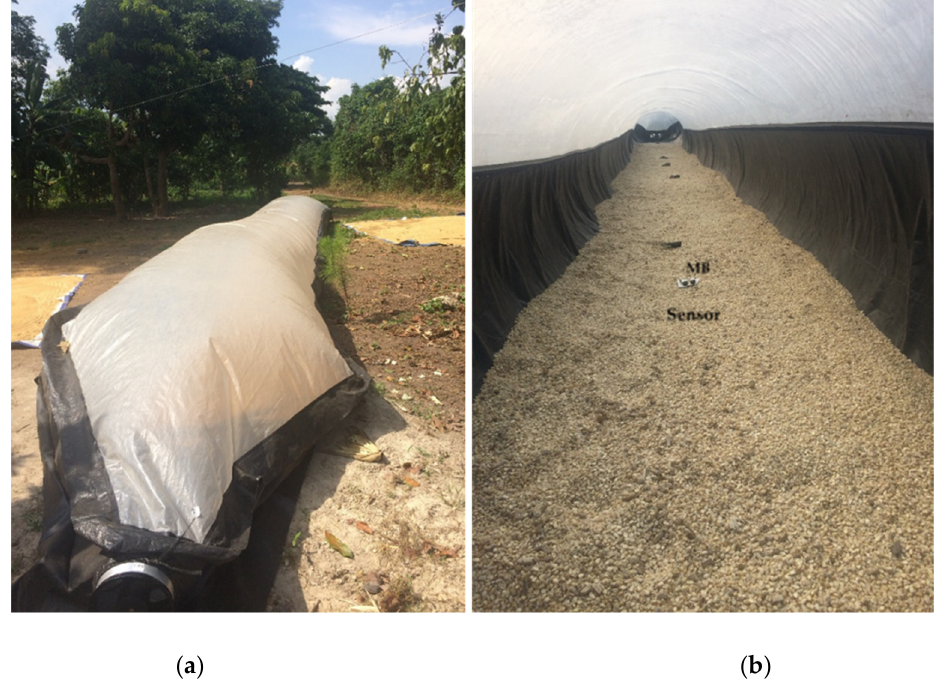
Figure 1. Inflatable solar dryer (ISD): ( a ) view from outside fully loaded with 1000 kg of maize and ( b ) inside view during the drying experiment showing the location of different sensors and mesh bags (MB).